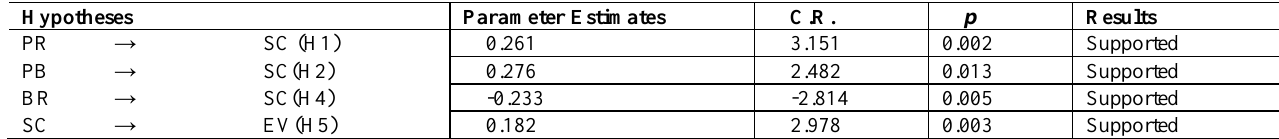
Table 7: Results of hypothesis